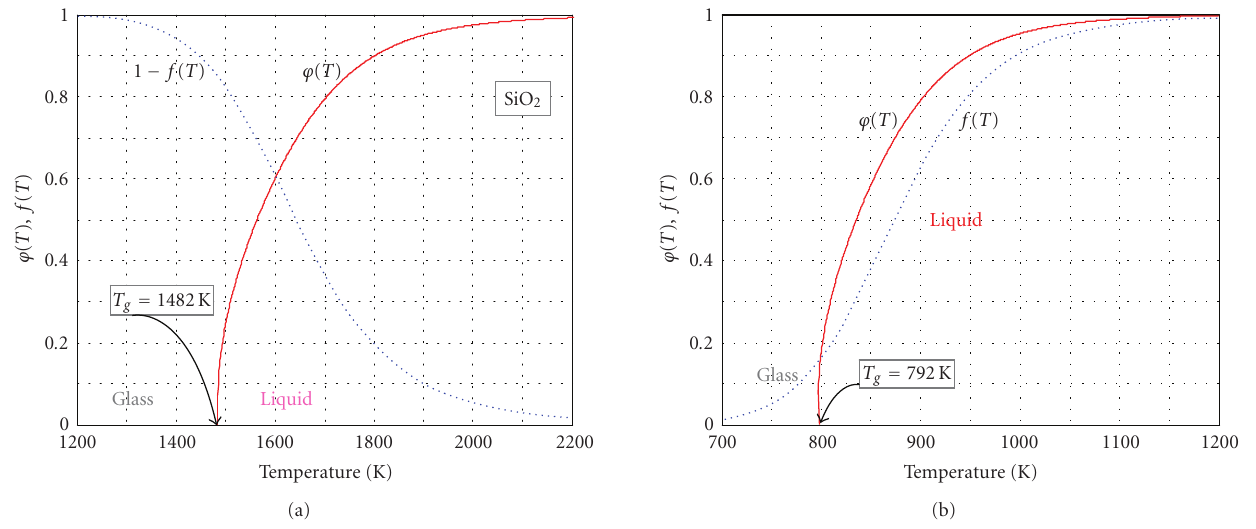
Figure 14: Temperature dependence of the order parameter of configurons in (a) amorphous SiO 2 (b) and GeO 2 [6]. The liquid phase seems more ordered for configurons (broken bonds) which are largely a part of the percolation cluster in the liquid whereas in the glassy phase the configurons are randomly distributed in the